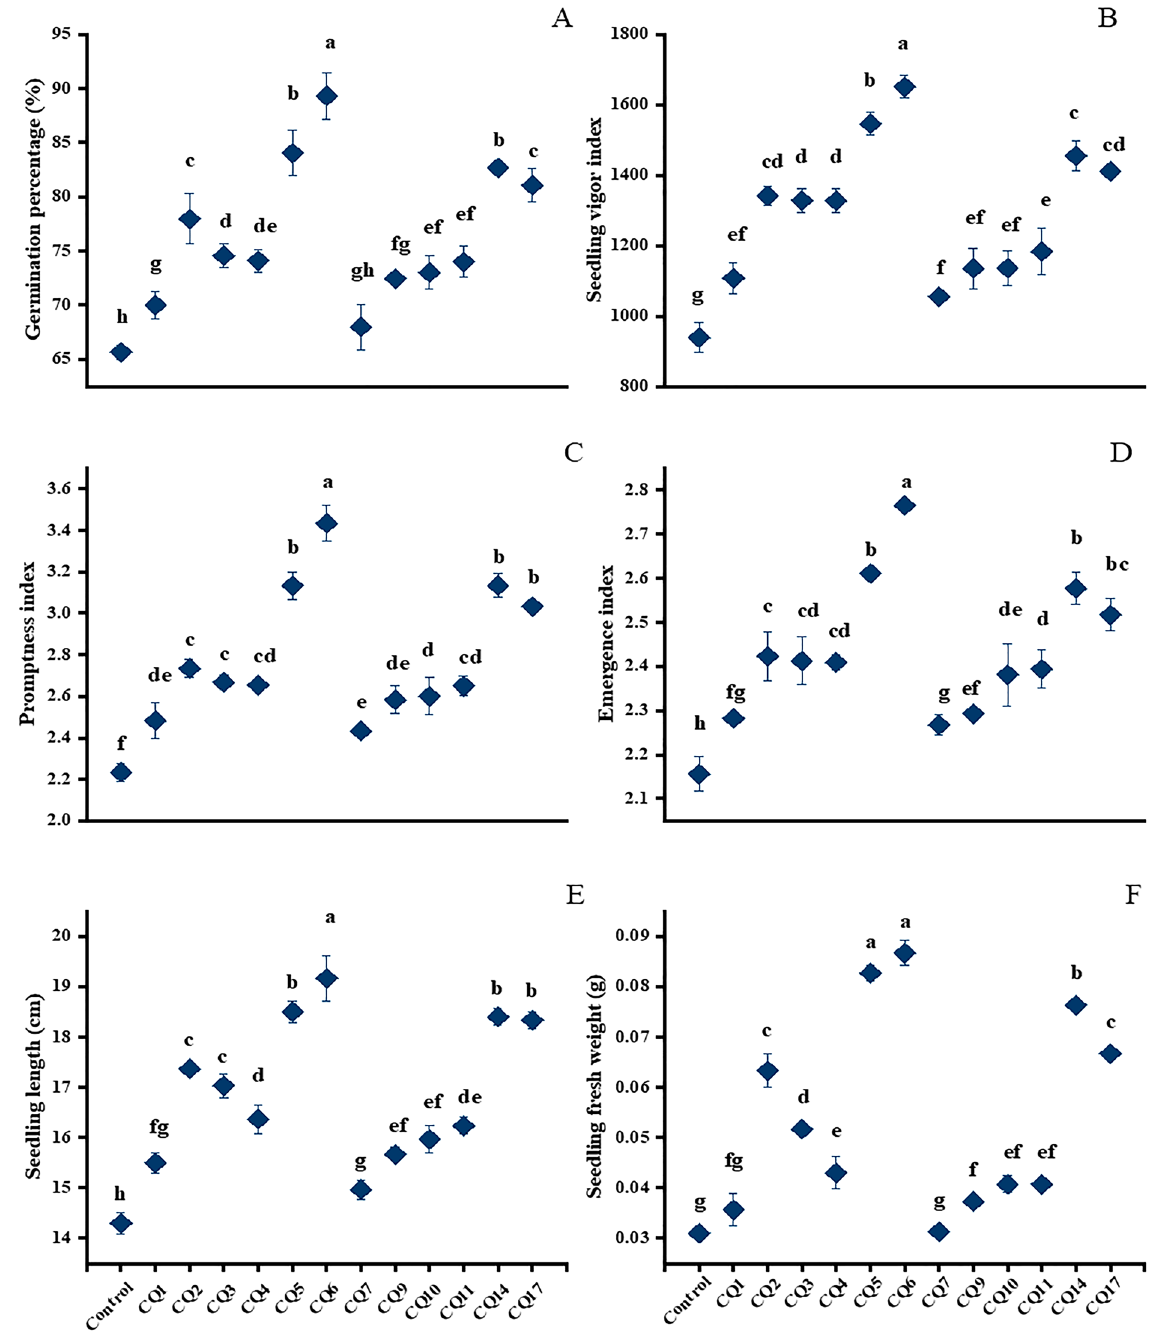
Figure 2. Growth promotion activity of rhizobacteria inoculated tomato seedlings in Petri plate experiment under axenic conditions ( A ) seedling length, ( B ) seedling fresh weight, ( C ) germination percentage, ( D ) seedling vigor index, ( E ) promptness index, ( F ) emergence index. Values are means of three replicates. Values with different letters are significantly different from each other at p ≤ Effects of selected bacterial strains on growth of tomato plants infected with A. alternata in pot experiment. From the in vitro experiment, nine bacterial strains were selected based on their antag- onistic and plant growth-promoting potential for an in-planta experiment. In this pot experiment, A. alter- nata infection significantly reduced all the growth parameters of the tomato plants compared to the uninfected healthy controls. In contrast, plants inoculated with selected bacterial strains along with pathogen infection showed significantly higher root and shoot lengths, as well as root and shoot fresh and dry weights compared to the plants inoculated with A. alternata alone (Table 3). A. alternata infection reduced tomato root and shoot lengths by 28 and 17%, respectively, compared to the uninfected untreated plants. However, all the plants with